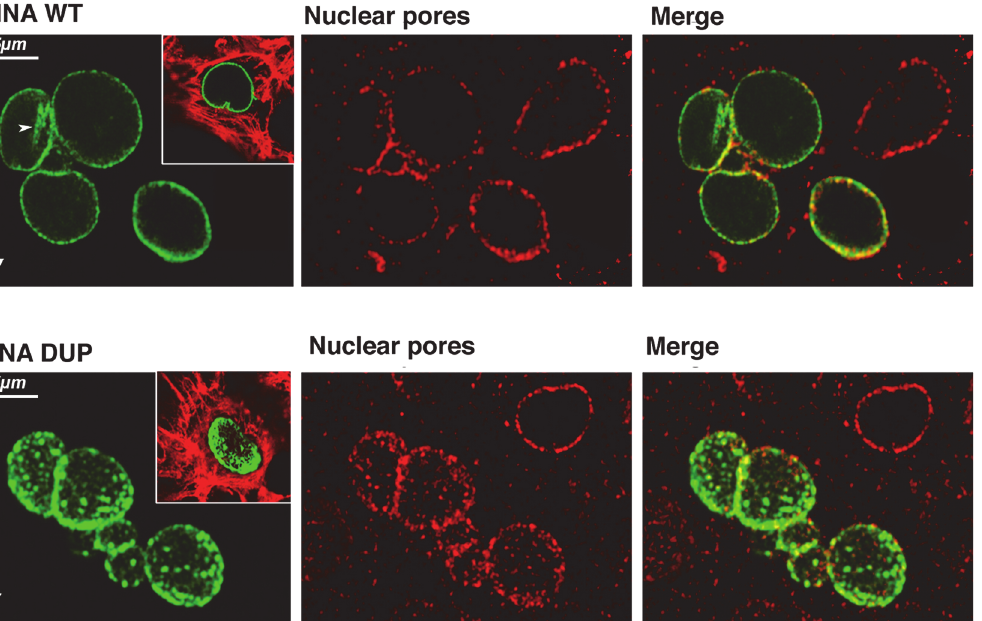
Fig 4. Immunofluorescence confocal analysis of LMNA transfected HL-1 cells. Cells transfected with both LMNA WT and DUP are depicted. LMNA is visualized in green, Nuclear Pores in red, and colocalization in yellow in the merge panels. In the insets, a merged image of LMNA and Phalloidin-TRITC is shown. Planar XY projections were depicted in each experimental